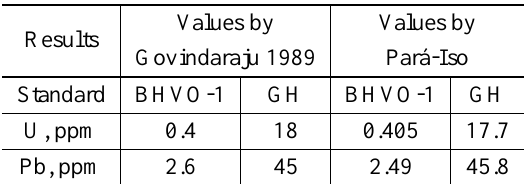
Concentrations of U and Pb in standards GH and